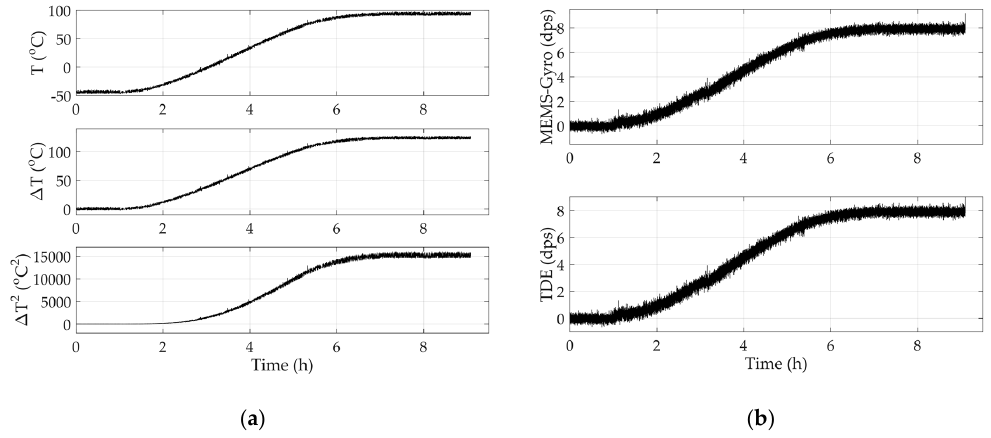
Figure 9. Experimental results of L3GD20. ( a ) ambient temperature and temperature variation as well as its square; ( b ) outputs of L3GD20 and its temperature drift error (TDE).